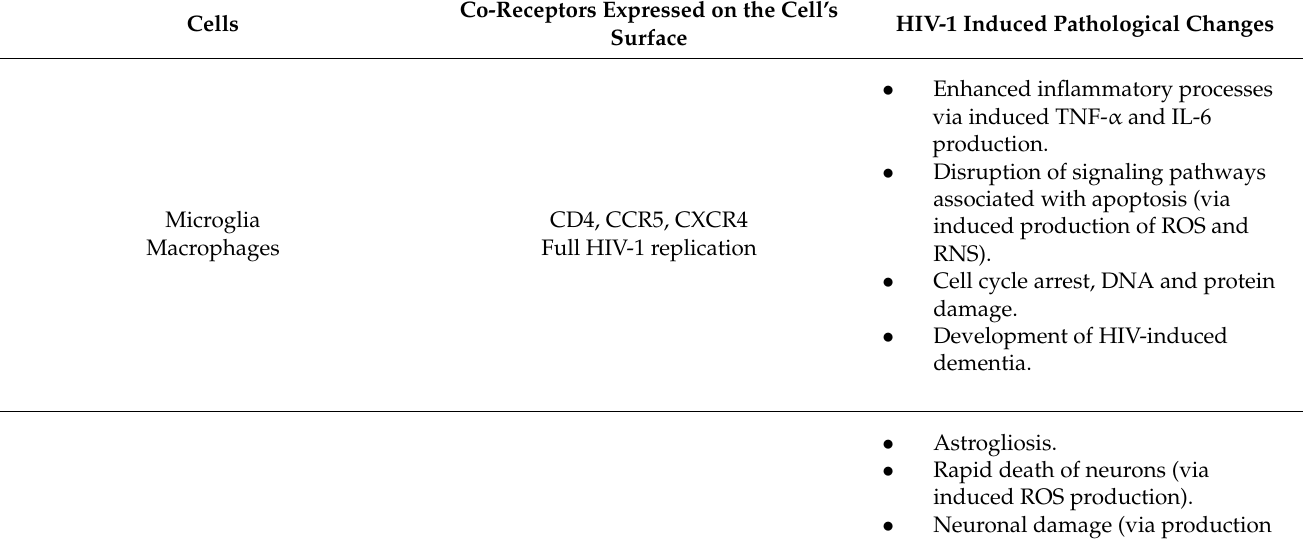
Table 1 summarizes the pathological effect caused by the HIV-1 on CNS cells. Table 1. Pathological changes in CNS cells induced by